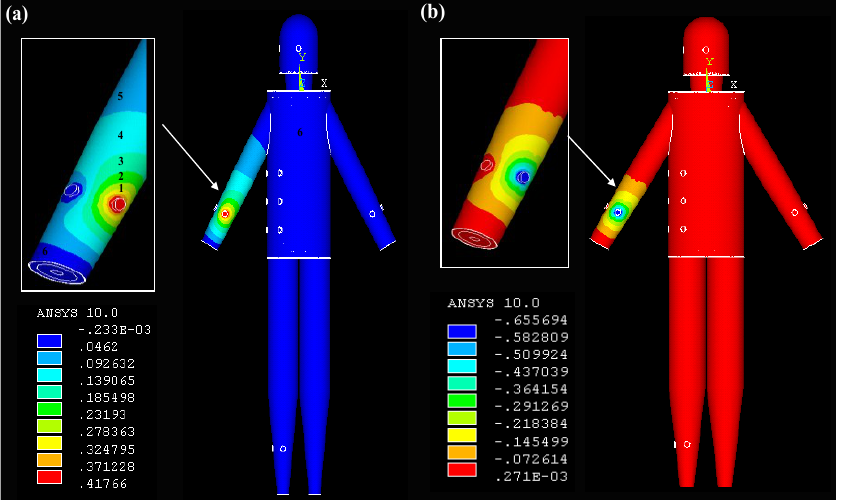
Figure 6. The real part ( a ) and the imaginary part ( b ) of the potential distribution when a signal transmits from the arm.